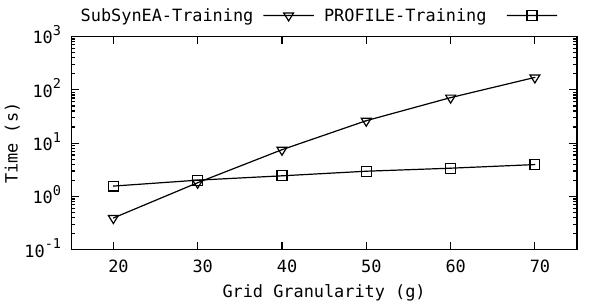
Figure 2. Runtime Efficiency of the Training Algorithms